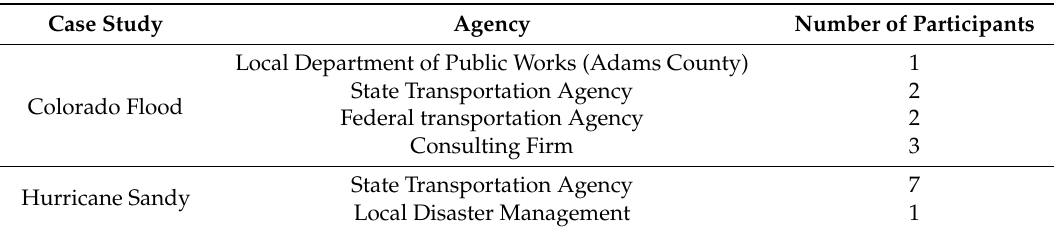
Table 2. Participants in data collection